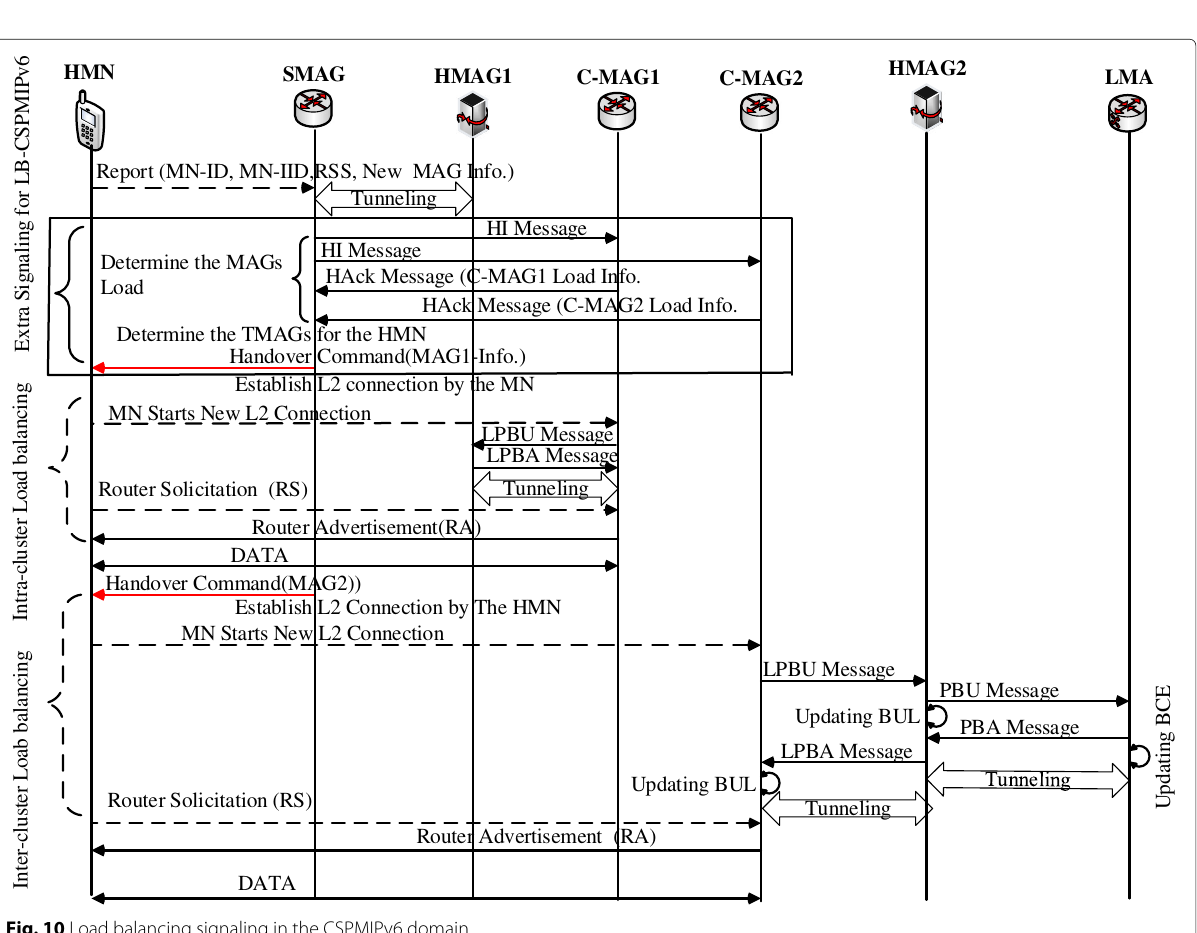
Fig. 10 Load balancing signaling in the CSPMIPv6